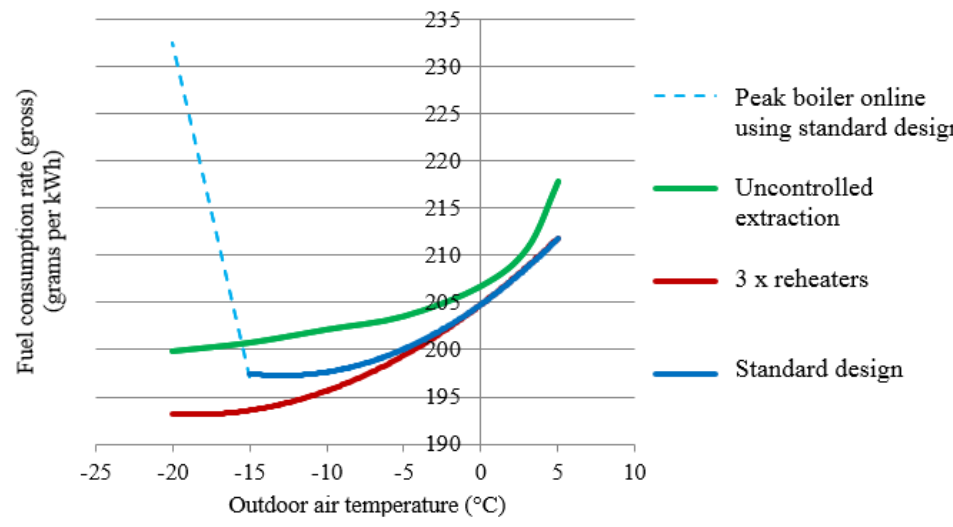
Figure 5. Plots of gross fuel-equivalent consumption rate as a function of outdoor air temperature for the standard design and designs involving three inline reheaters with controlled and uncontrolled extraction.